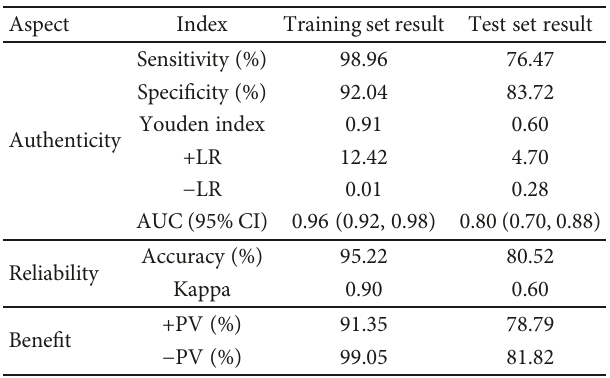
Table 5: Decision tree model